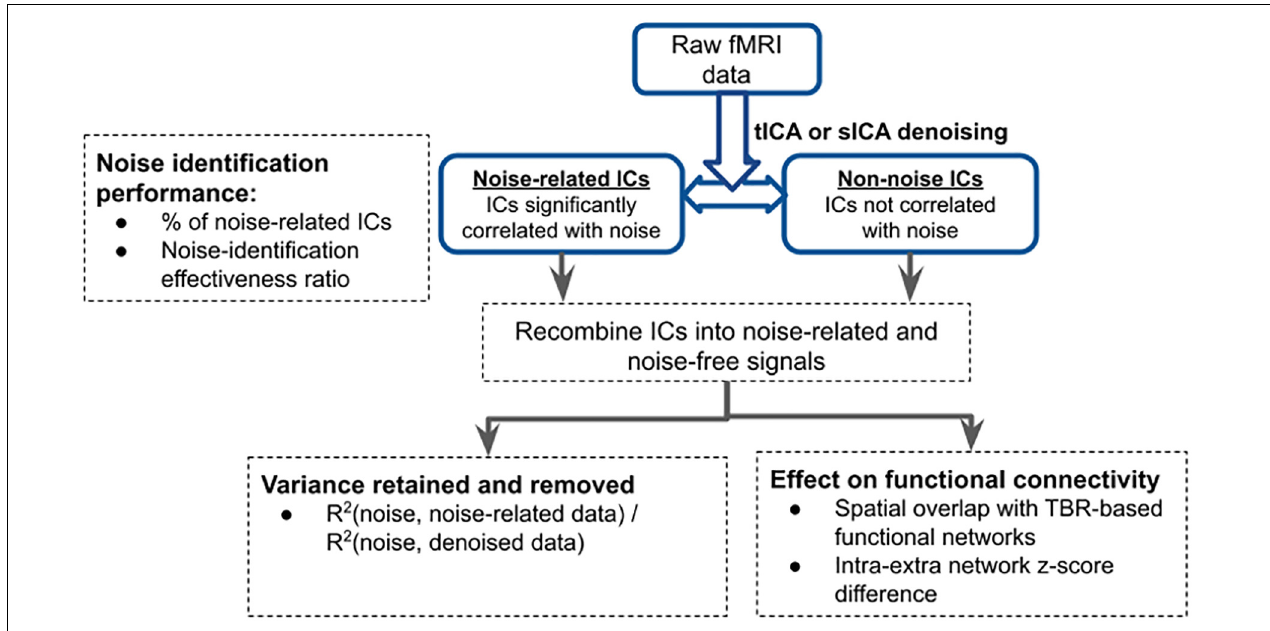
FIGURE 2 | Overview of analysis pipeline for evaluating the performance of tICA and sICA. The performance of the two approaches are compared in three ways: (1) noise identification: the associated metrics are extracted from the results of the ICA step; (2) functional connectivity: these are extracted after combining noise-related and noise-free components to create noise and cleaned datasets; (3) variance explained: the amount of variance (of the original data) that is removed from the pre-ICA signal (as noise) and how much is retained (noise-free), as well as the variance accounted for by the noise markers. TABLE 1 | Rubric demonstrating how to interpret the performance of noise identification (A) and correction (B) based on the presented data. Evaluation of noise detection performance Evaluation of noise removal